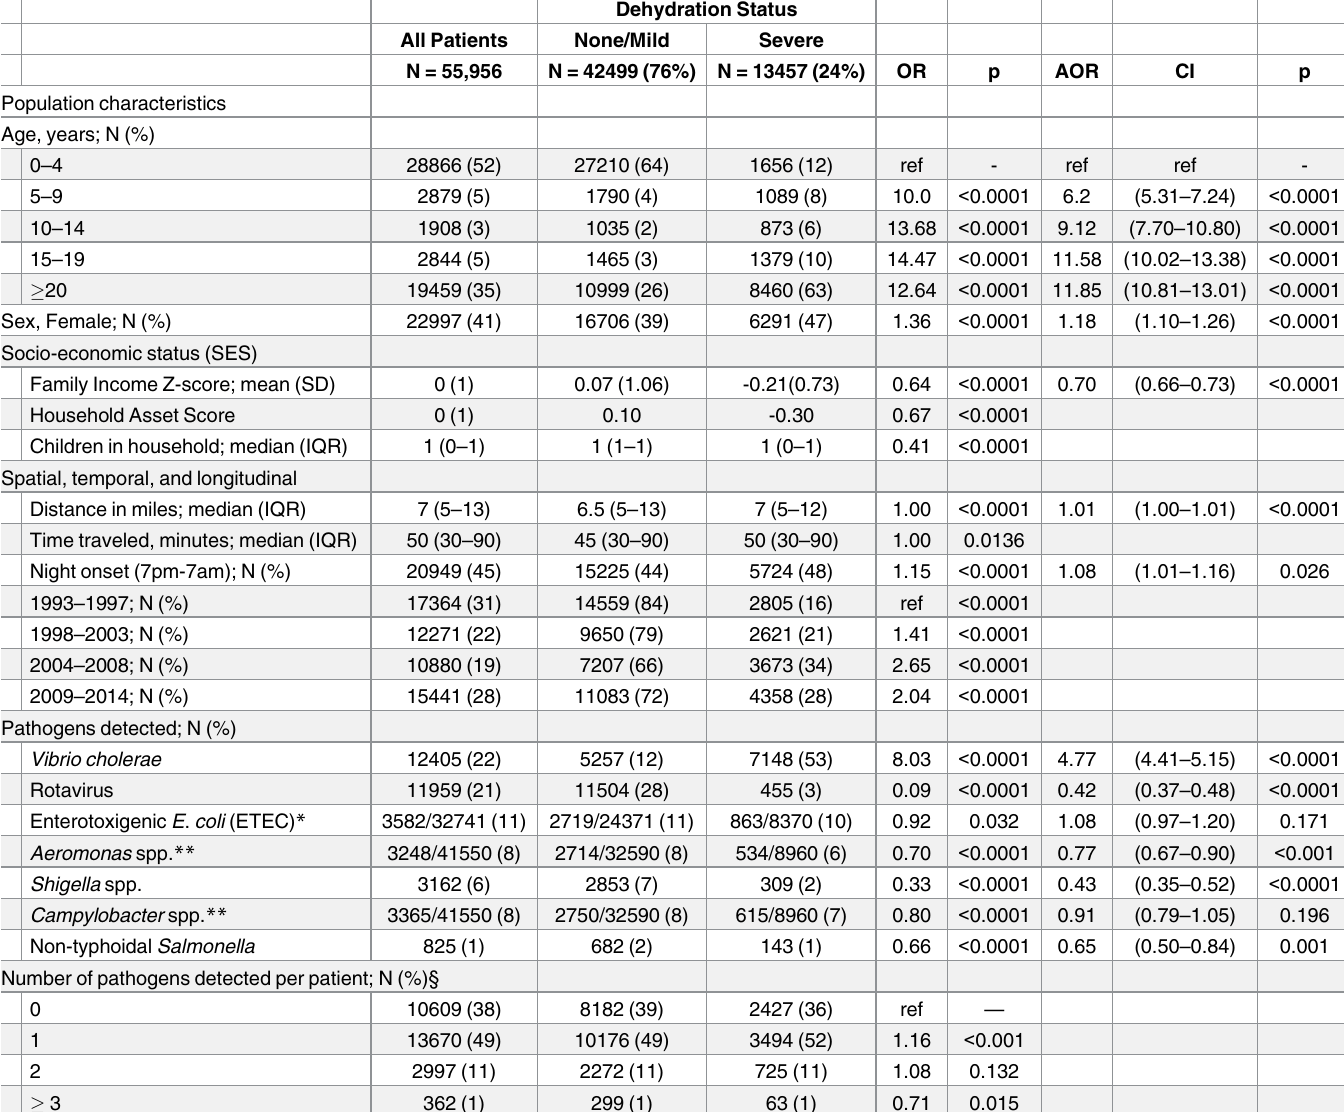
Table 1. Population characteristics and microbiologic findings for individuals presenting with and without